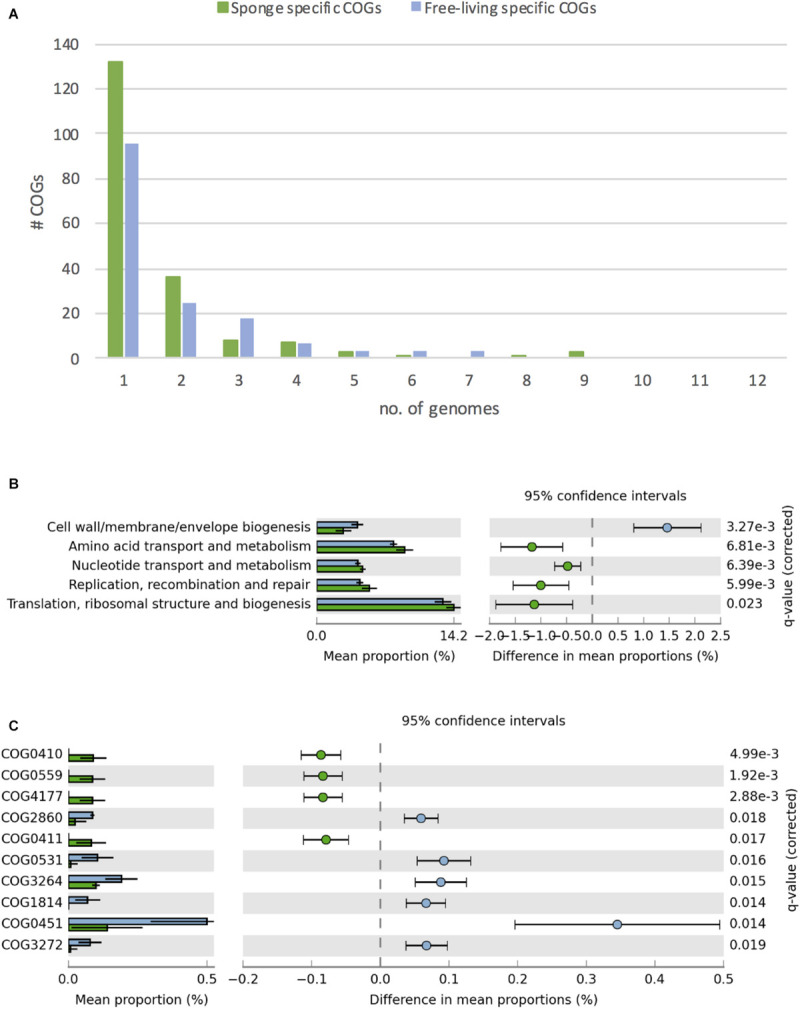
Differences in COGs between free-living (blue) and sponge-associated (green) Thaumarchaeota. (A) Distribution of free-living and sponge symbiont specific COGs among genomes. The maximum for free-living Thaumarchaeota is 12 and for sponge-associated ones is 11 genomes. (B) COG classes with significant differences in free-living vs. sponge symbiont genomes (t-test, FDR Benjamin-Hochberg corrected p-value <0.05). (C) Distribution of COGs with significant differences (t-test, FDR Benjamin-Hochberg corrected p-value <0.05). COGs 0410, 0559, 4177, and 0411 are part of the branched chain amino acid transporter. Free-living enriched COGs were related to an amino acid transporter (COG0531), a Fe2 + /Mn2 + transporter (COG1814), a small-conductance mechanosensitive channel (COG2364), a nucleoside-diphosphate-sugar epimerase (COG0451), an uncharacterized membrane protein (COG2860), and a protein of unknown function (COG3272).